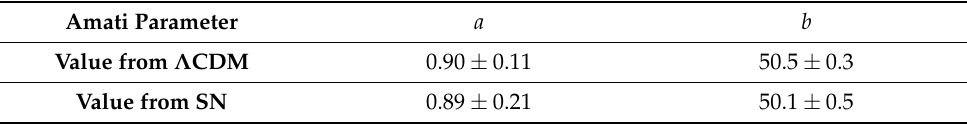
Figure 5. Left : the plane of the log E iso –log E p, i parameters (the Amati plane). Each LGRB is repre- sented by the large green point with the error bars and the underlying “Monte-Carlo cloud” of the size of 10,000 (small green dots). The plot also shows the line and the confidence region that corresponds to the estimated a and b parameters with their errors and covariance. Right : the Monte-Carlo sample corner plot for the Amati parameters a and b . The error borders are defined as the 0.16 and 0.84 quantiles. Top : all 174 LGRBs, distances taken from Λ CDM. Bottom : subsample of 75 LGRBs with z < 1.4, distances taken from SN HD theoretically justified approximation function with p = 2. Table 1. Calibration results of the Amati parameters for all LGRBs calibrated by the Λ CDM model and for the near LGRBs calibrated by SNe